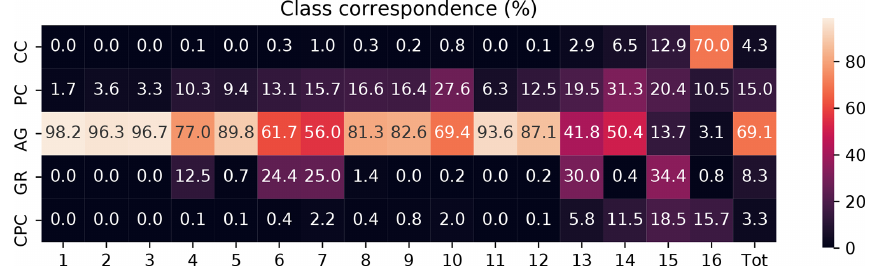
Figure 9. A heatmap showing the correspondence between our 16-class classification and the P17 classes. Each column has been normalized to sum to 100%, and the last column shows the class memberships in the entire dataset. The P17 classes are abbreviated as follows: CC (columnar crystals), PC (planar crystals), AG (aggregates), GR (graupel), and CPC (combinations of plates and